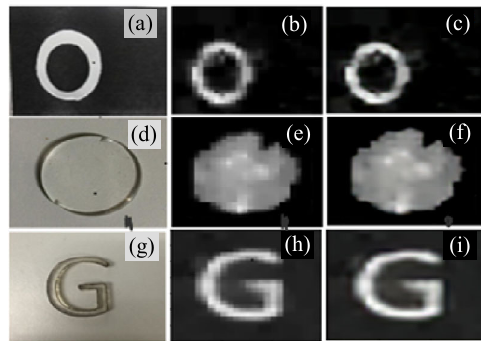
Fig. 7 2D image reconstruction results from the transparent object imaging system. Original images for transparent object reconstruction are illustrated in (a), (d), and (g), reconstruction using compressive sensing in (b), (e), and (h), and reconstruction using CS-SRCNN in (c), (f), and (i).